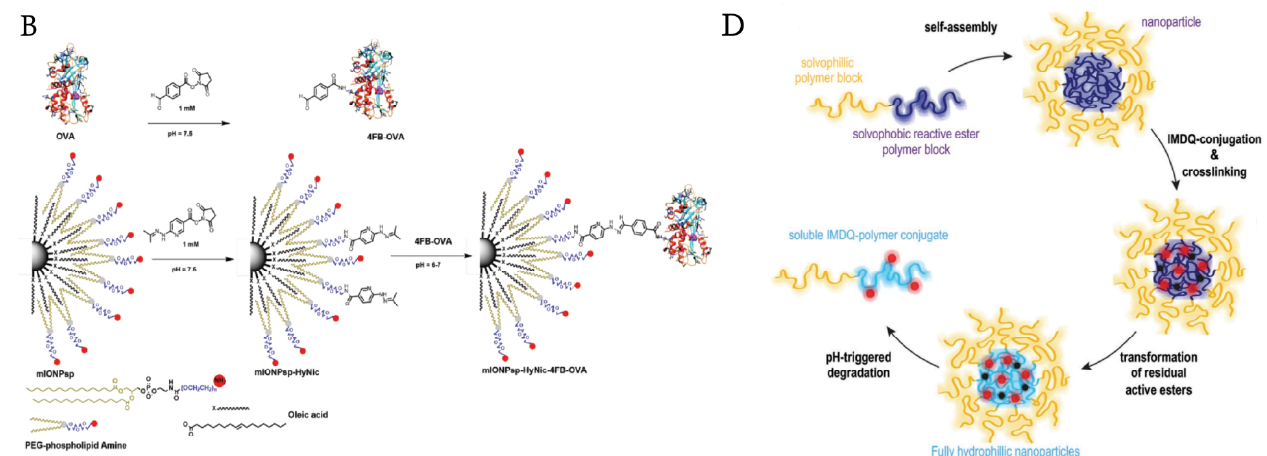
Figure 3. ( A ) General strategy for the conjugation of the antigen (OVA) to mIONPsp. ( B ) Schematic of the self-assembly process for the synthesis of the water-soluble and pathogen-mimicking nanoparticles (NP micelles (mNP) incorporating Xcc or E. coli LOS molecules). ( C ) The function of pathogen-mimicking magnetite nanoparticles via the TLR4 pathway.Reprinted with permission from Ref. [84]. Copyright 2018, copyright Wiley-VCH. ( D ) Schematic representation of the fabrication of IMDQnano. Reprinted with permission from Ref. [76]. Copyright 2018, copyright Wiley-VCH.